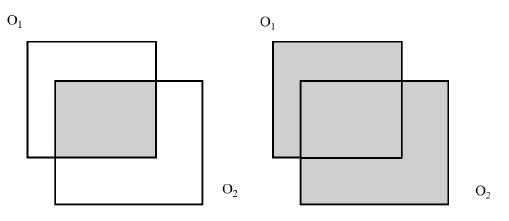
Figure 11. Intersection and union of predicted bounding box and the real one.